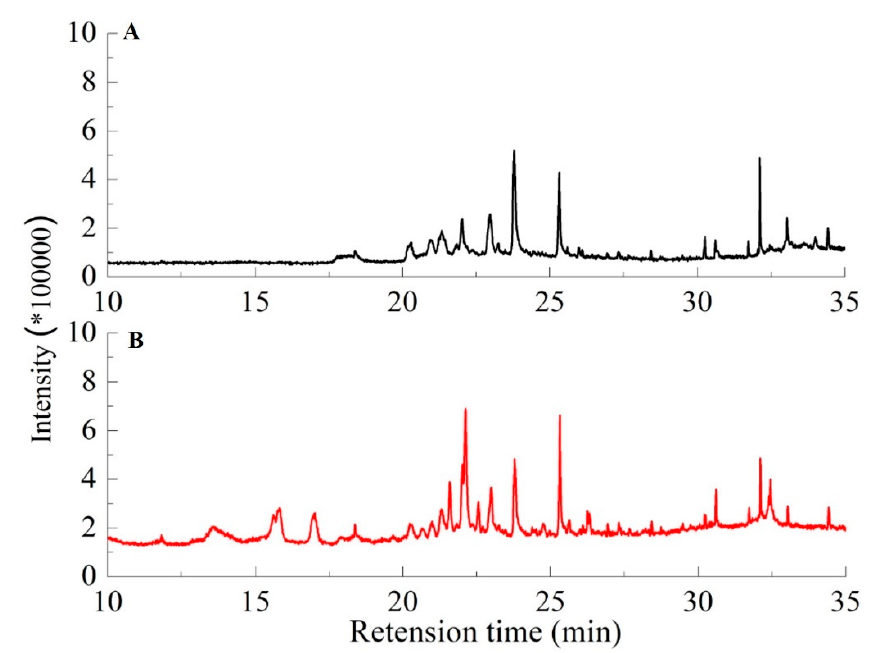
Figure 4. GC-MS chromatogram of products generated from hydrothermal degradation of lignin without ( A ) and with ( B ) solid acid catalyst of SAC-3 under the conditions of 290 °C, 8.2 psi for 30 min.